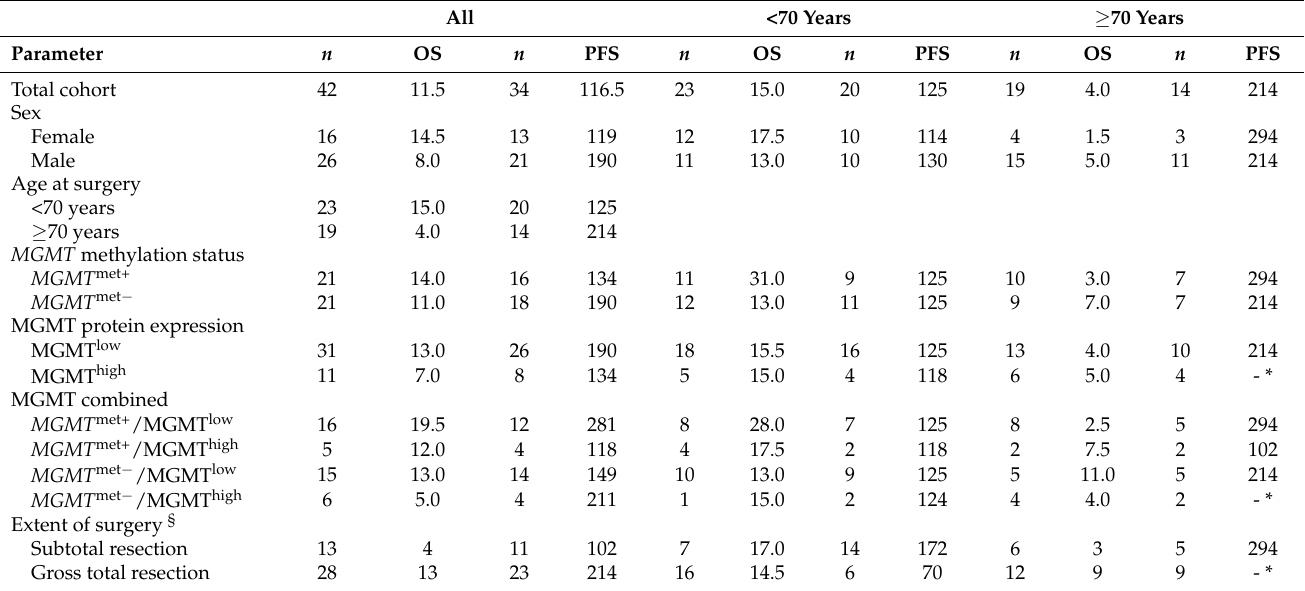
Table 2. Overall survival (OS) and progression-free survival (PFS) in patients with glioblastoma WHO grade IV. The data are shown for all patients (All), patients younger than 70 years of age (<70 years) and patients with an age of 70 years or more ( ≥ 70 years). The median OS and PFS are given in months and days after surgery,